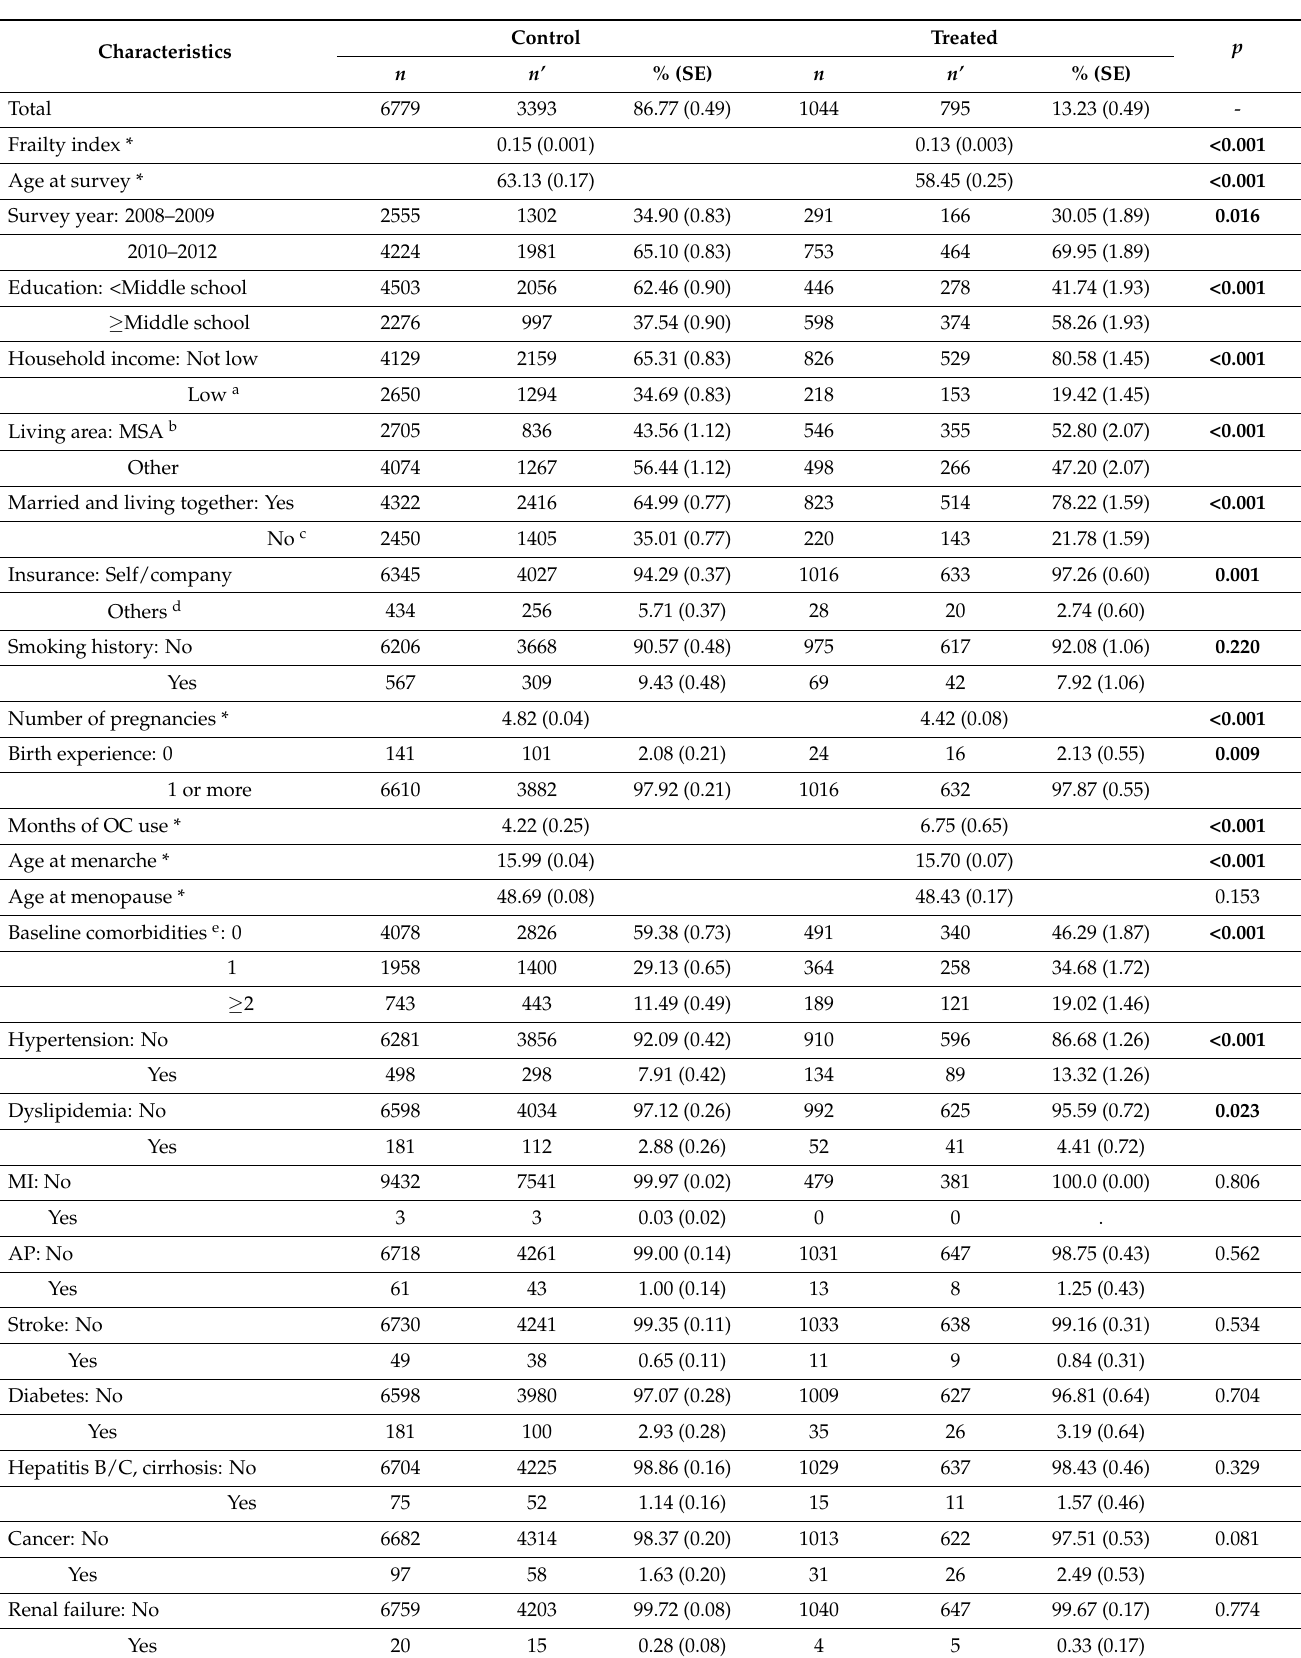
Table 2. Comparison of characteristics between treatment